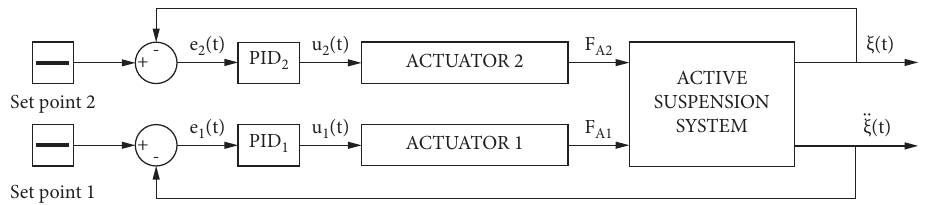
Figure 3: The diagram of the double-integrated controller. Table 1: Specific parameters of the vehicle.